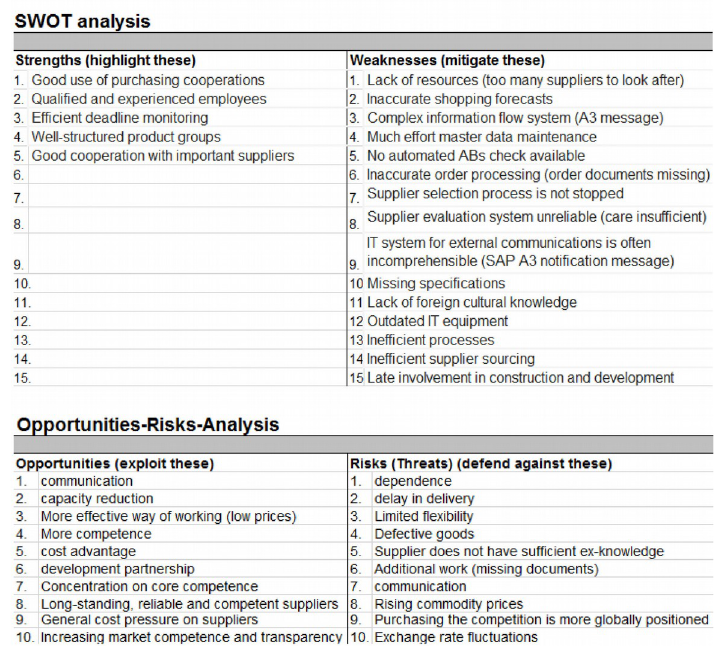
Figure 5. SWOT analysis. Case study